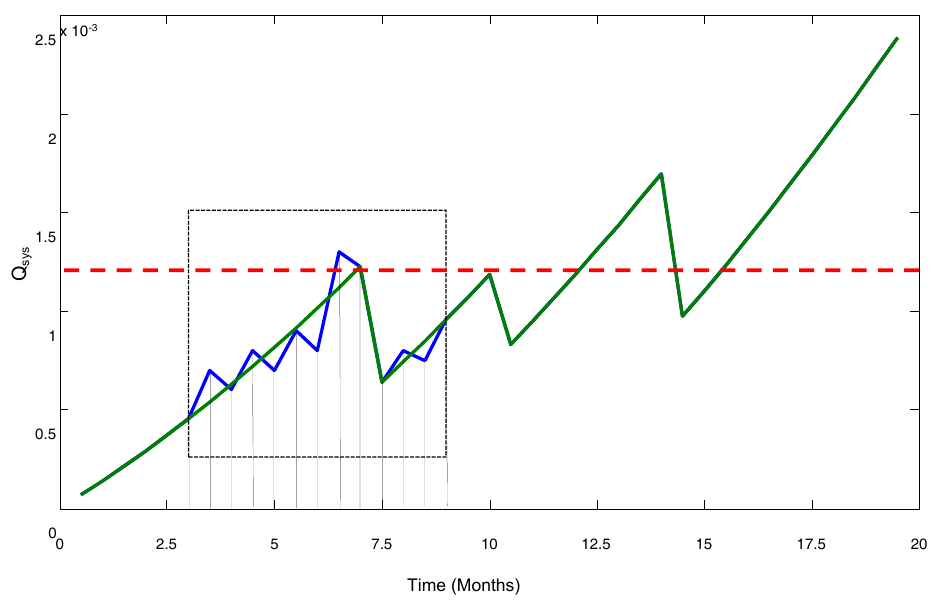
Figure 11. Q sys ( t ) with time variable increment.